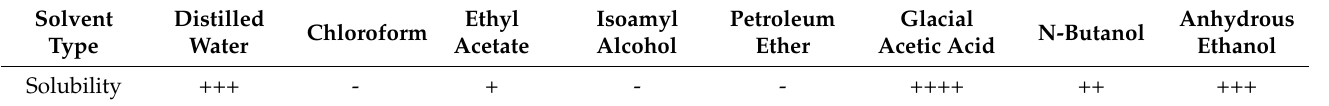
Table 1. The solubility of the pink pigment in organic solvents.